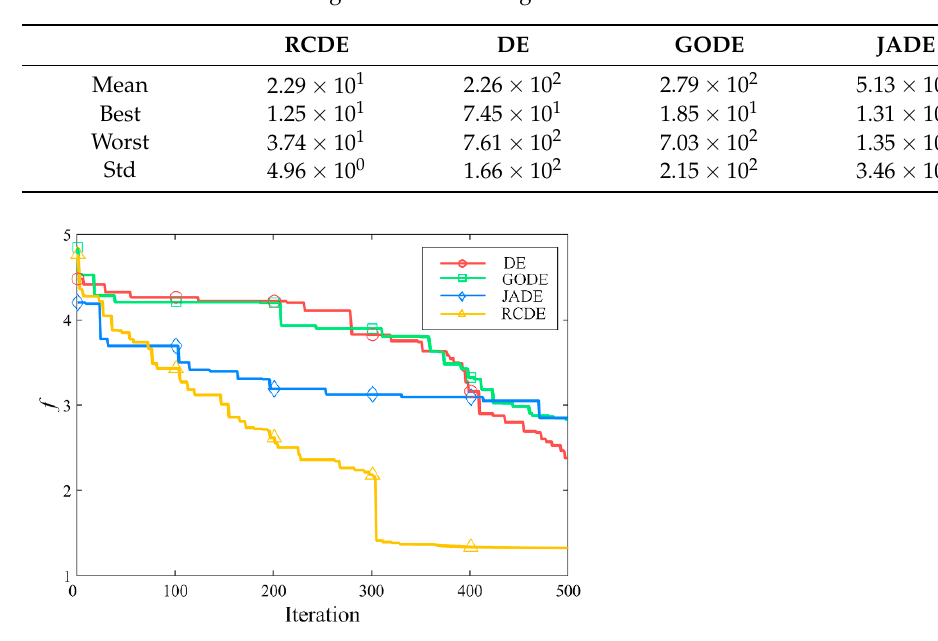
Figure 11. Convergence curves of the four algorithms in Case 3.